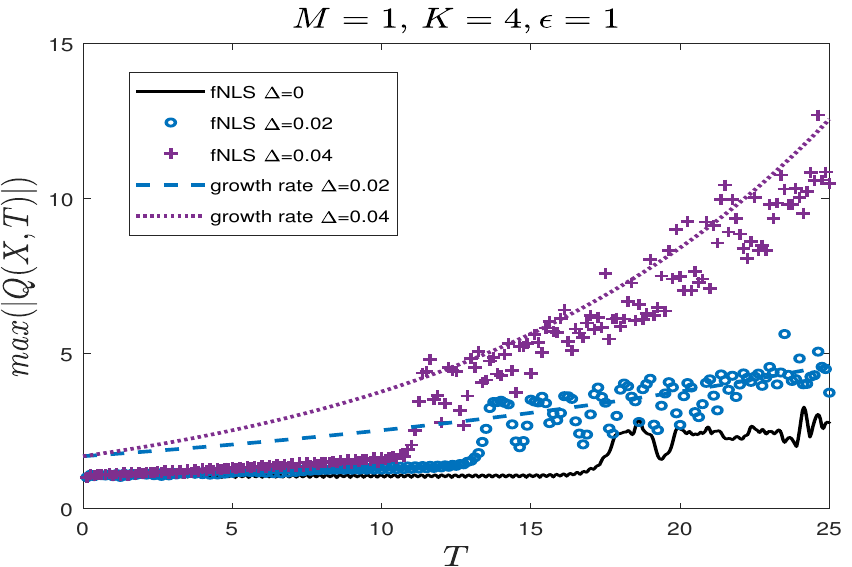
Figure 20. Case 4: The initial condition is (14). Maximum of | Q ( X , T ) | and growth rate 2 ∆ when M = 1.0, (cid:101) = 1.0, K = 4.0 for various values of ∆ .